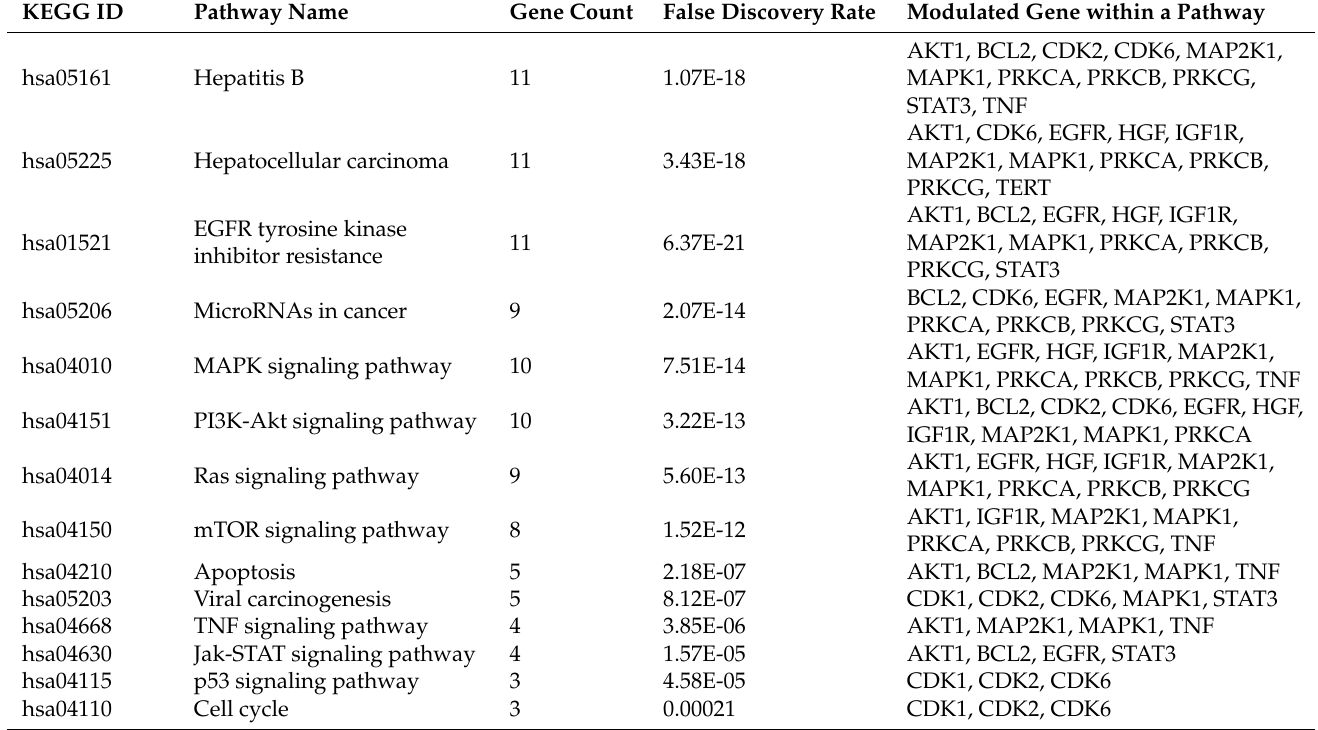
Table 3. Pathways involved in HBV infection and associated hepatocellular carcinoma modulated by the